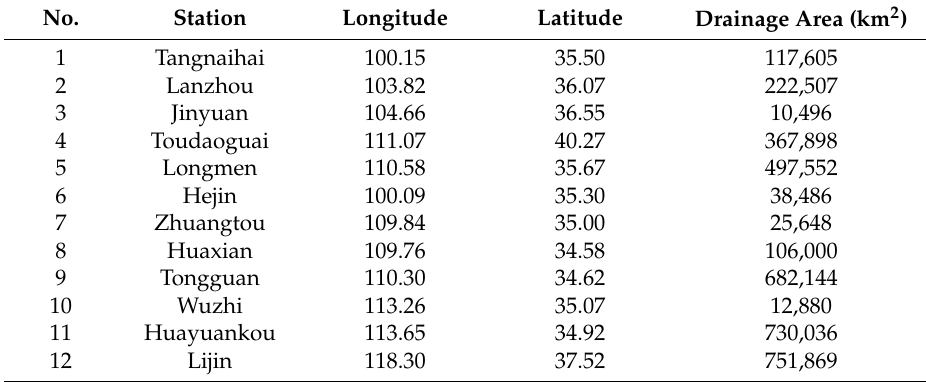
Table 1. Locations of drainage areas of the 12 hydrological stations in the Yellow River Basin used in this